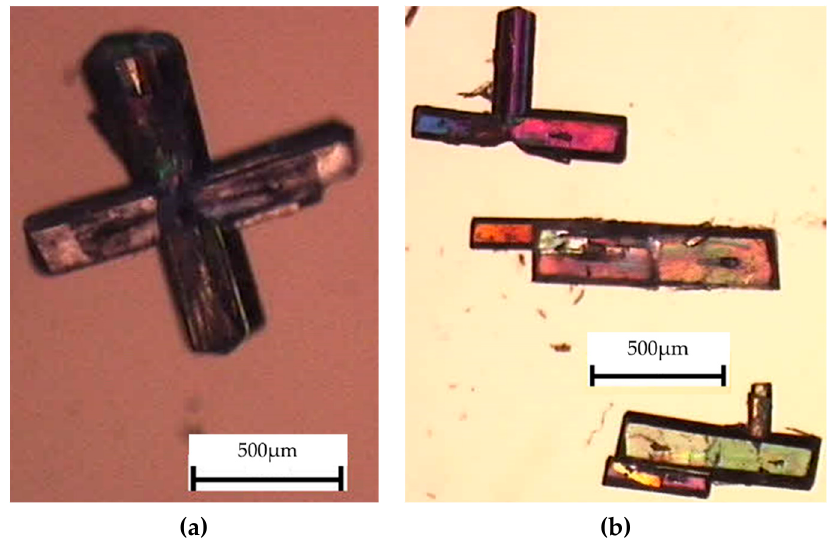
Figure 7. Photographs taken by binocular polarized light microscopy of the observed ‘parts’ of the S-IBU/S- α MBA crystals. They seem connected by a zone roughly perpendicular to the main axis ‘a’ of the elongated particles. ( a ) Crystal with four visible parts; ( b ) crystals with two or three visible parts.